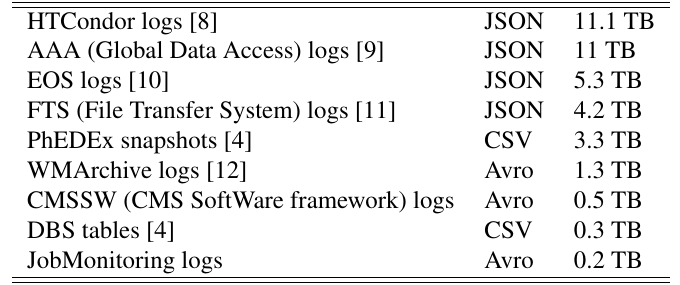
Table 1. Current snapshot of CMS metadata on HDFS stored on